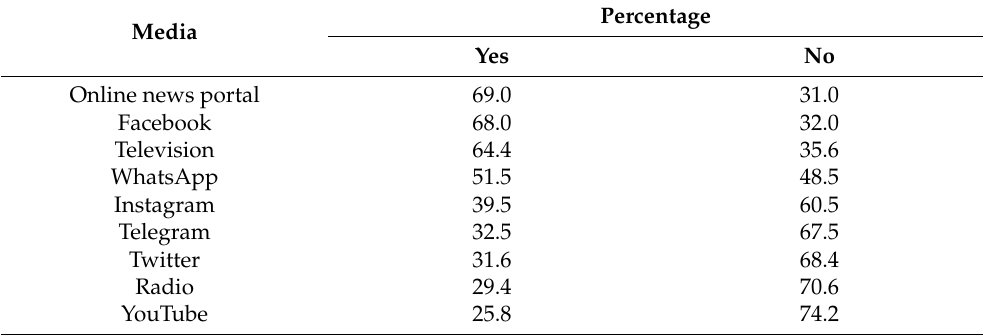
Table 3. Media platforms used for COVID-19 vaccine